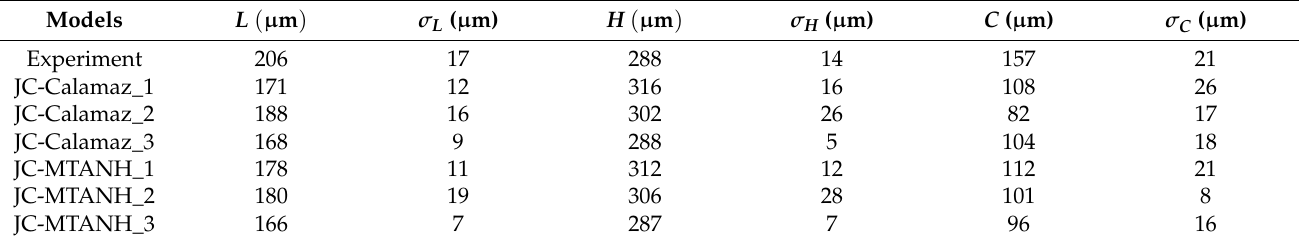
Table 11. Numerical saw-toothed chip measurement of tooth length, L, the tooth height, H , the valley, C and the standard deviation of the length x for h = 280 µ m, σ x